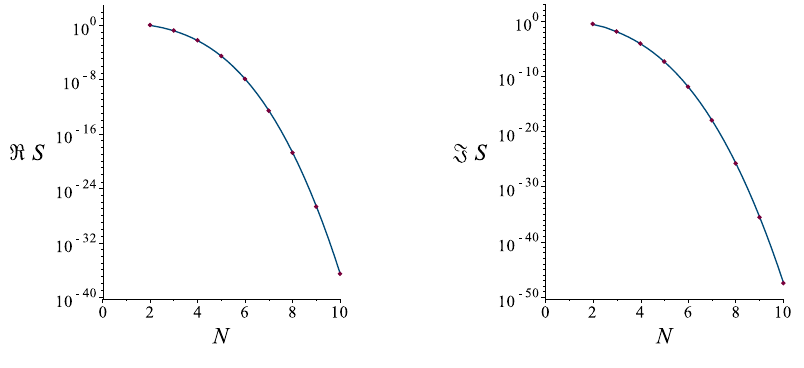
q 2 (cid:25) Z N +1 (red dots) with the lateral g s